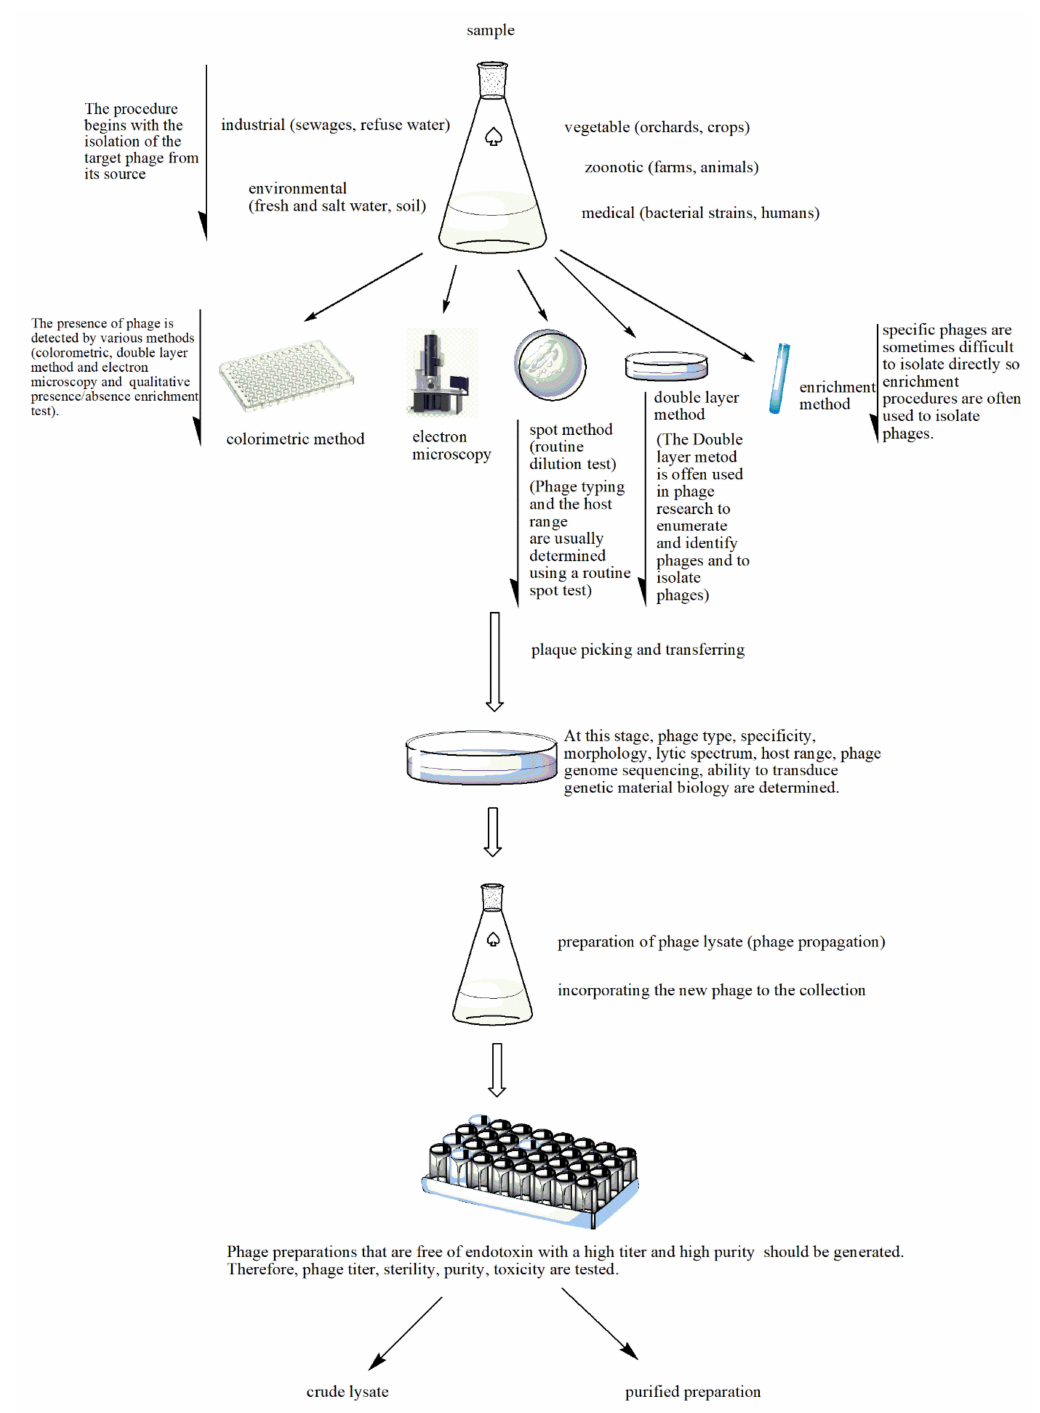
Figure 2. Stages of phage preparation. The environment (e.g., wastewater, farms and soil) is a source for all types of phages. The presence of phages in the tested sample is determined by different methods such as the double layer agar method, spot assays, the colorimetric method, the enrichment method or electron microscopy. The plaques that indicate lytic activity are picked up and transferred for the determination of phage type, specificity, etc. A phage lysate is prepared. At this stage, multiple procedures are performed to check for sterility (microbial contamination), toxicity (bacterial endotoxin or lipopolysaccharide (LPS) quantification), bacterial DNA contamination and phage titer. The purified phage preparation is